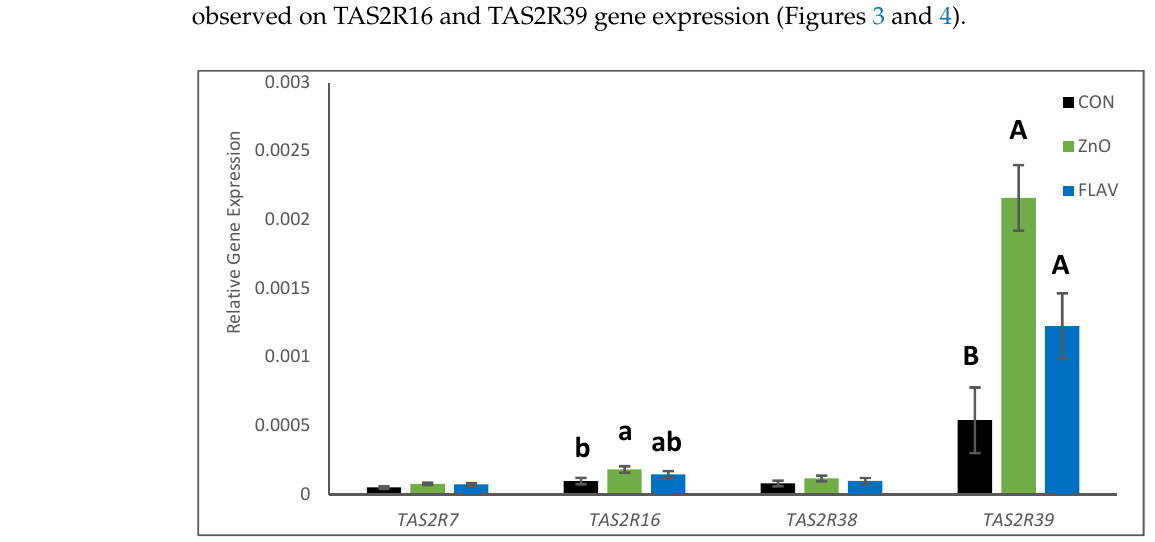
Figure 4. Gene expression of TAS2R of pigs fed the experimental diets analyzed by tissue. * Means statistically different ( p < 0.05). 3.4. Microbial Molecular Analysis No effect of the experimental diet was observed for alpha estimators ( p > 0.10; Table 5). Beta diversity analysis revealed distances between clustered samples of the FLAV and CON groups (PADONIS = 0.023; Figure 5). At the genus level, when pig diets were supplemented with zinc oxide, there was a decrease in the relative abundance of several genera such as Lactobacillus , Desulfovibrio , Anaerovibrio , Lachnospira , Lachnobacterium , and Actinobacillus compared to the CON diet ( p < 0.05; Figure 6). Whereas, when the FLAV diet was offered to pigs the relative abundance of genera such as Dorea , Desulfovibrio , and Actinobacillus , among others, decreased com- pared to the CON diet ( p < 0.05; Figure 7). Interestingly, the abundance of several genera of bacteria such as Lactobacillus , Roseburia , and Clostridium increased compared to the CON diet ( p < 0.05; Figure 7). Comparing the FLAV diet to the ZnO diet, an increased abundance of Mitsuokella , Lactobacillus , Megasphaera , Succinivibrio , Veillonella , Streptococcus , and Fibro- bacter (p < 0.10; Figure 8) was observed. Table 5. Evenness and diversity of colon microbiota of weaned pigs fed experimental diets 1 . Item